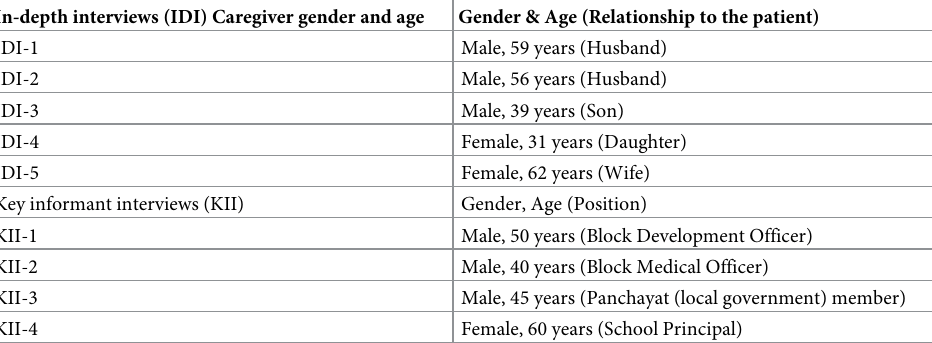
Table 2. Participant characteristics of In-depth interviews and key informant